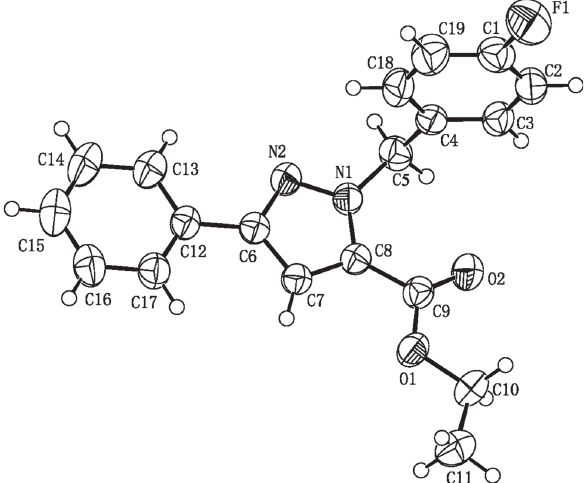
Table 1: Data collection and